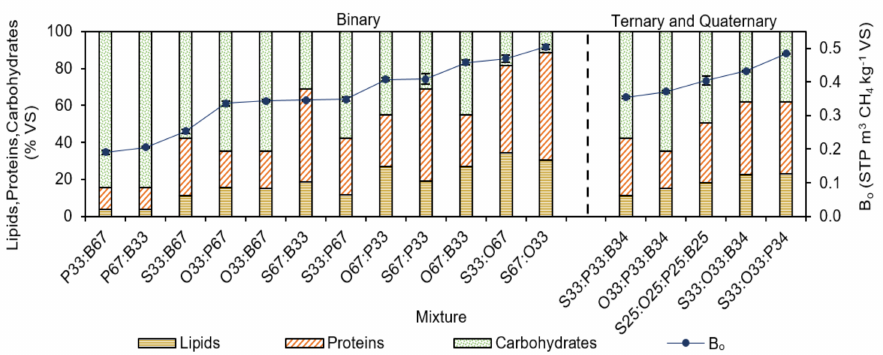
Figure 3. Biochemical composition of the different AcoD mixtures (left axis) and the resulting ultimate specific CH 4 yield (right axis). On the X-axis, the letter represents the waste stream (S: slaughter wastewater; O: offal wastewater; P: paunch wastewater; B: bovine manure) and the number its %VS in the